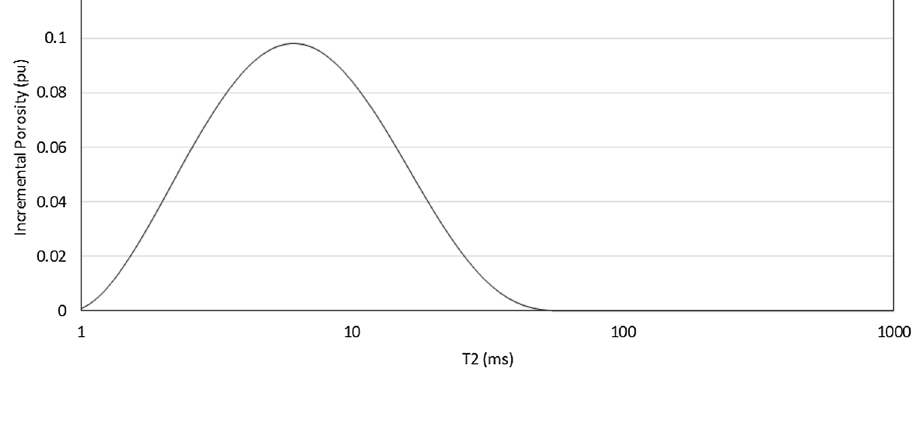
Fig. 2 T 2 distribution curve (residual saturation-sample 33)